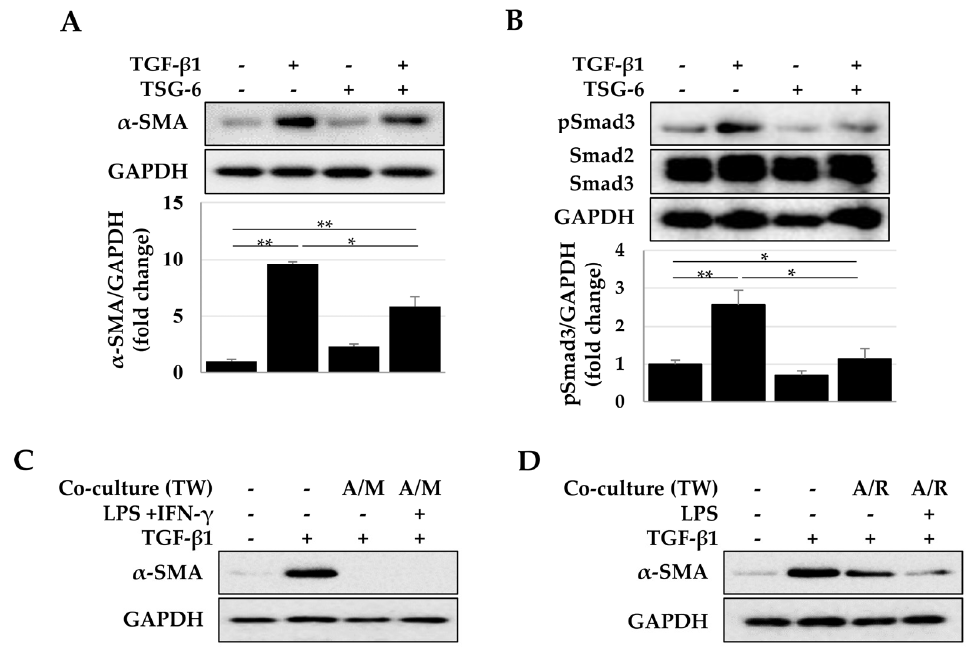
Figure 6. Antifibrotic effects of TSG-6 in TGF- β -treated LX-2 cells. ( A ) Inhibition of α -SMA expression by TSG-6 in TGF- β -treated LX-2 cells. ( B ) Inhibition of Smad3 phosphorylation by TSG-6. Expression of α -SMA ( A ) and pSmad3 ( B ) was quantified by densitometry using Image J, and relative expression was normalized with respect to GAPDH expression. Data are presented as the mean ± SD of three independent experiments. * p ≤ 0.05 and ** p ≤ 0.01. LX-2 cells in the lower chamber were cocultured with ASCs and macrophages seeded in the upper chamber. Inhibition of α -SMA expression in LX-2 cells cocultured with ASCs and macrophages ( C ) or ASCs and RAW 264.7 macrophages ( D ). TW,